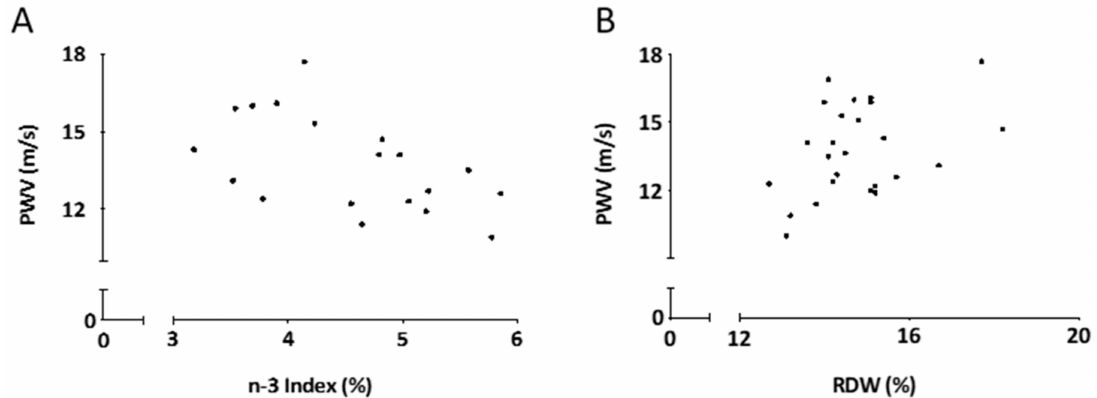
Figure 1. Relationship between pulse wave velocity (PWV) and omega-3 index ( A ) and PWV and red blood cell distribution width (RDW) ( B ) at baseline in patients with